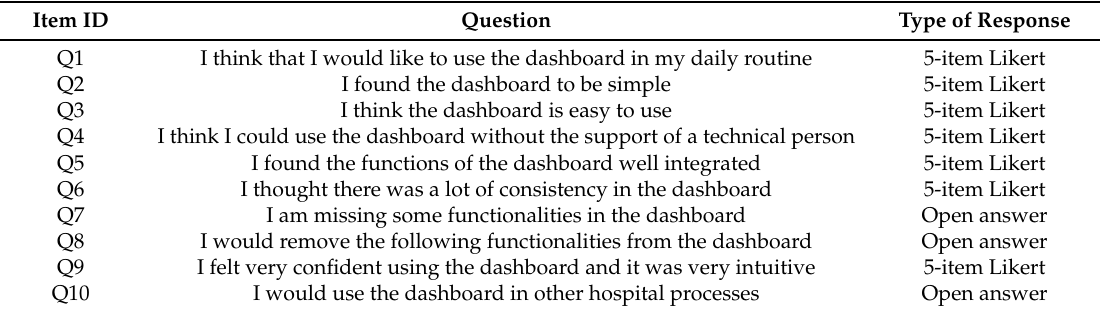
Table 4. Questionnaire for the qualitative study of the dashboard usability.